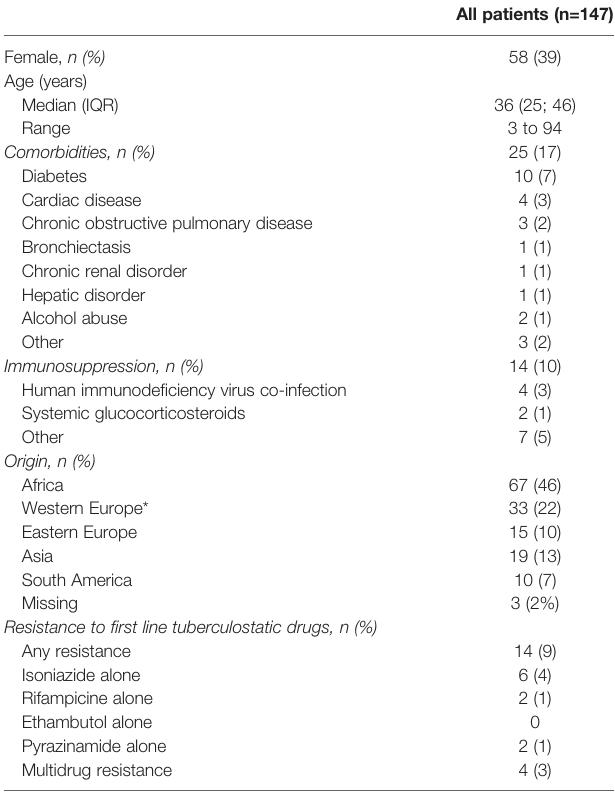
TABLE 1 | Patients ’ characteristics (n=147 patients).